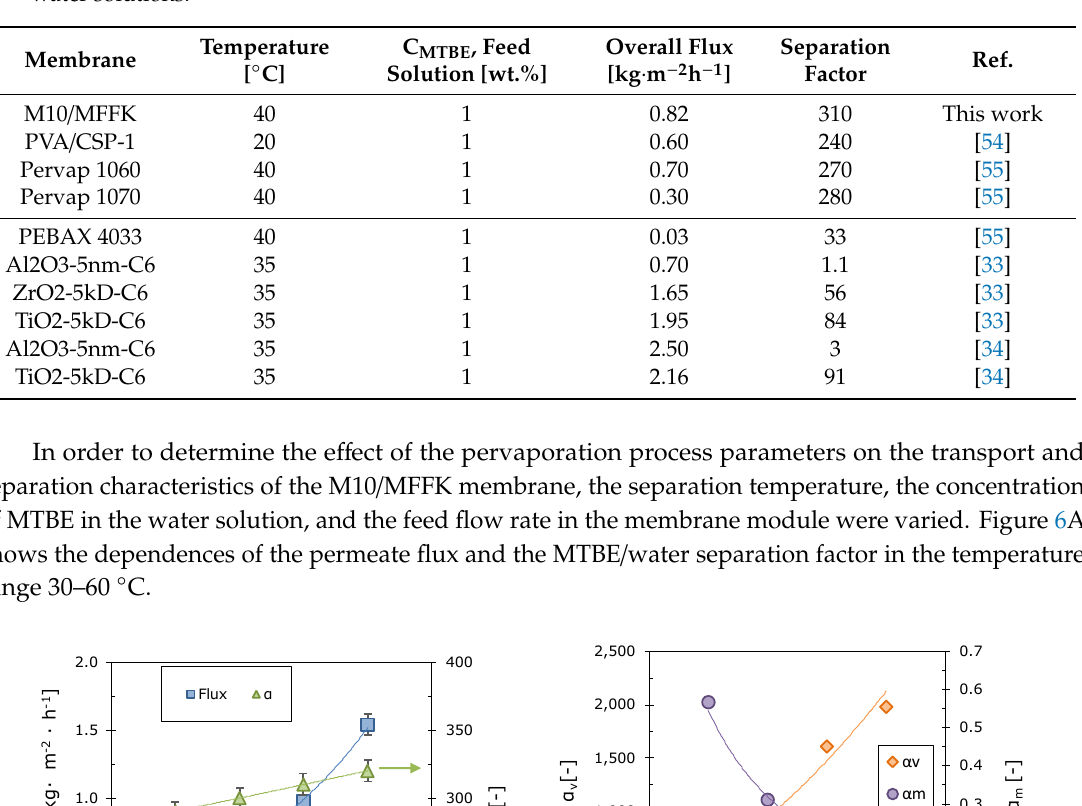
Table 3. Pervaporation characteristics of composite membranes used for the removal of MTBE from water solutions.